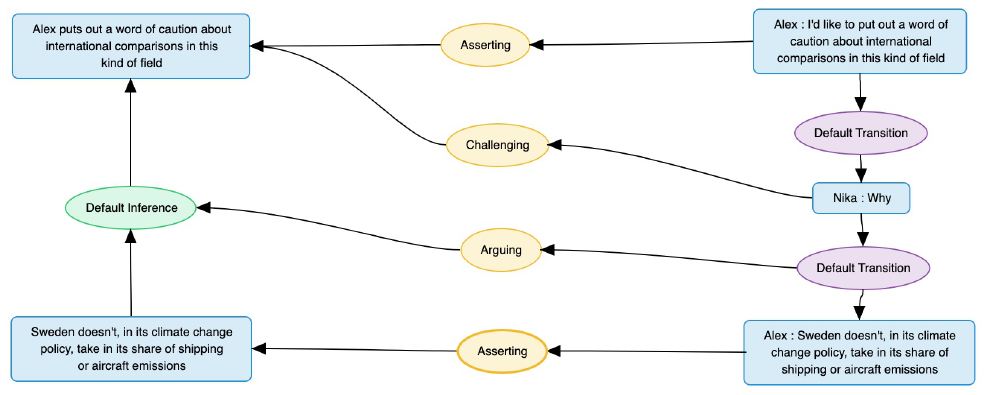
Figure 1. IAT diagram for Example